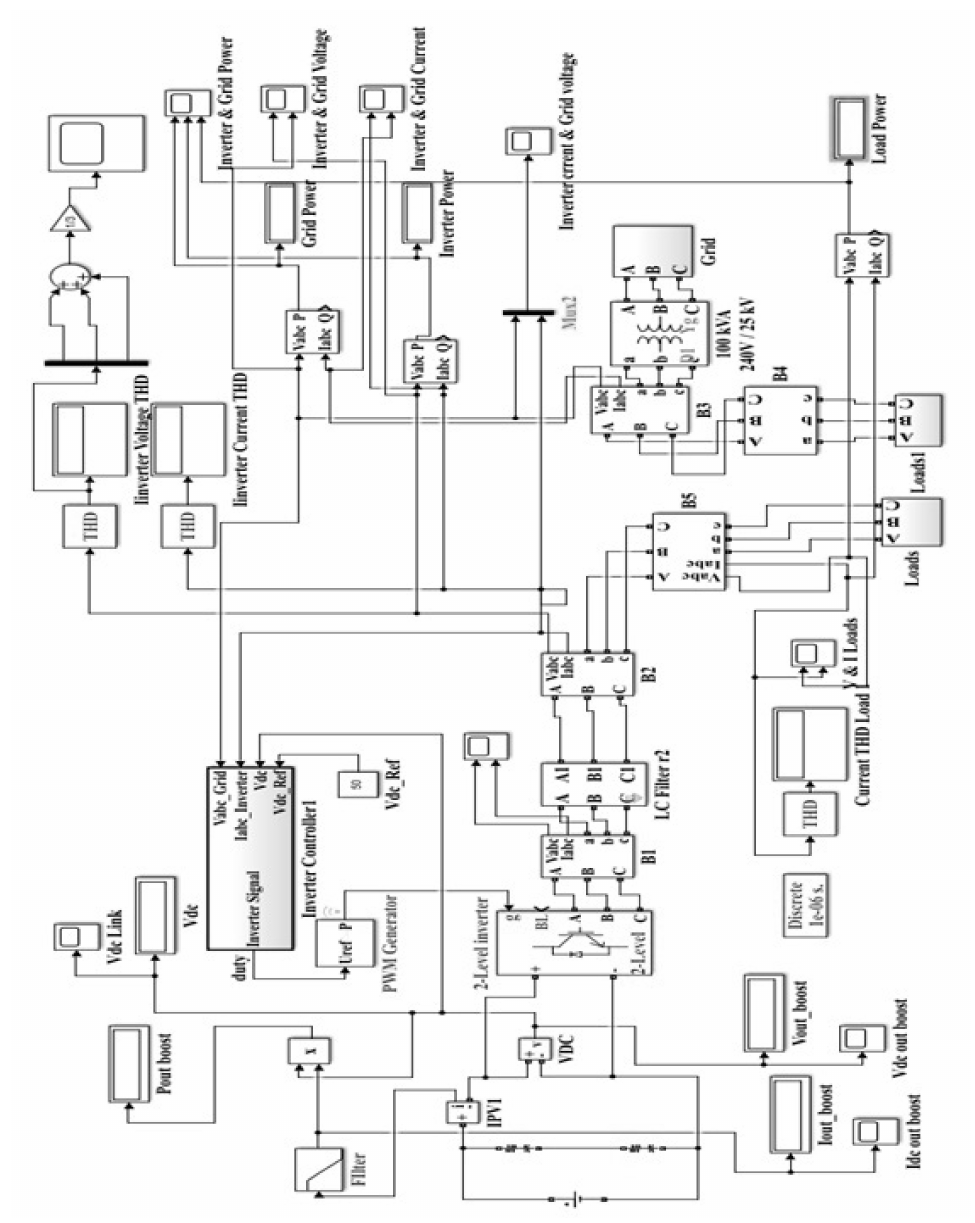
Figure 1. Complete Simulink model of the grid-connected photovoltaic